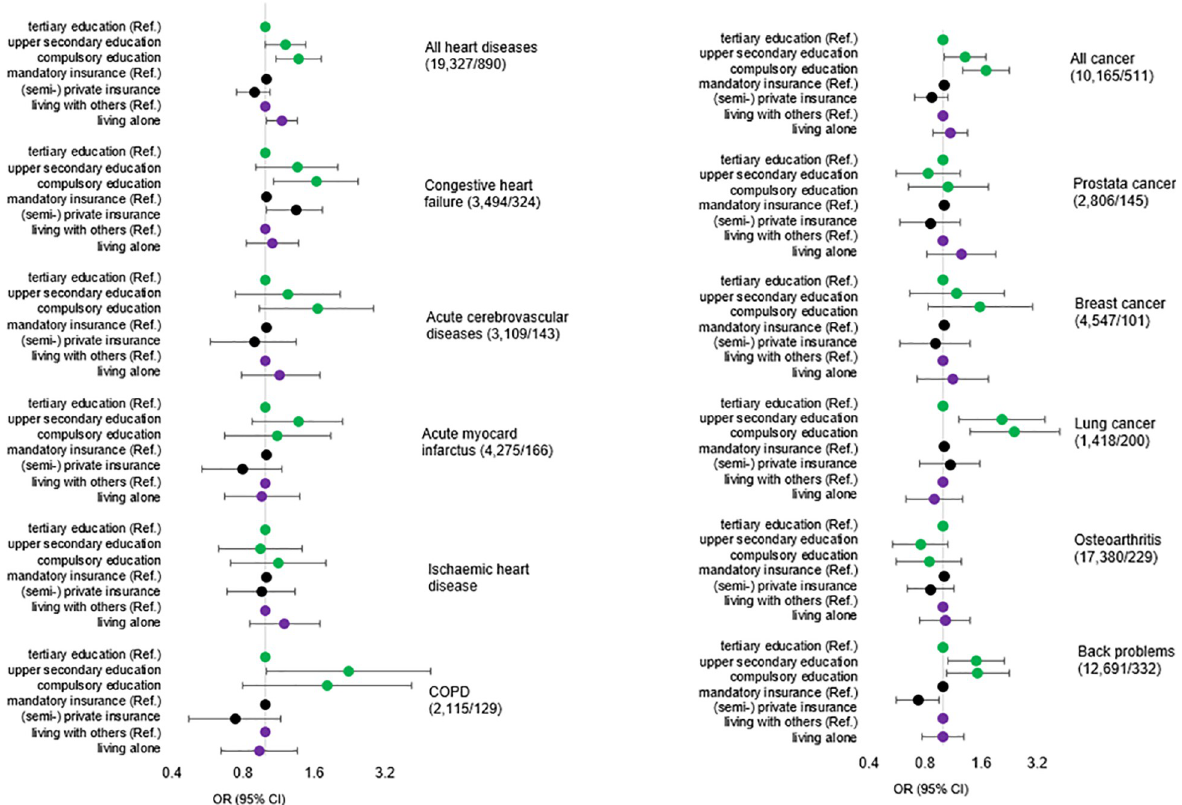
Fig 4. Odds ratios of unplanned 30-day readmission for social factors, by chronic condition, adjusted by demographics, comorbidity, hospital admission in previous six month and length of hospital stay.